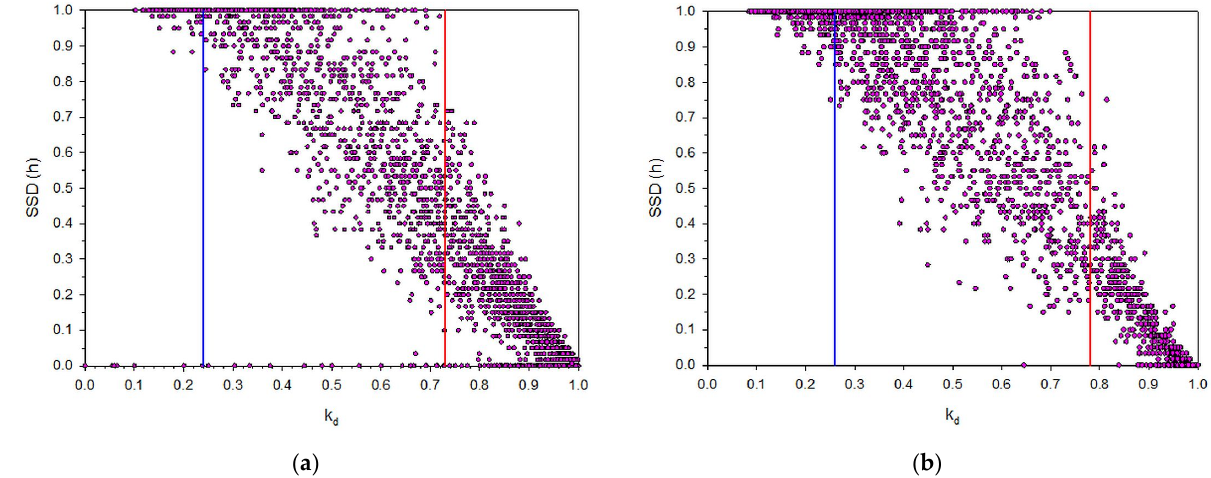
Figure 15. Determination of clear, intermediate, and overcast skies for the ( a ) LER and ( b ) LIN sites.